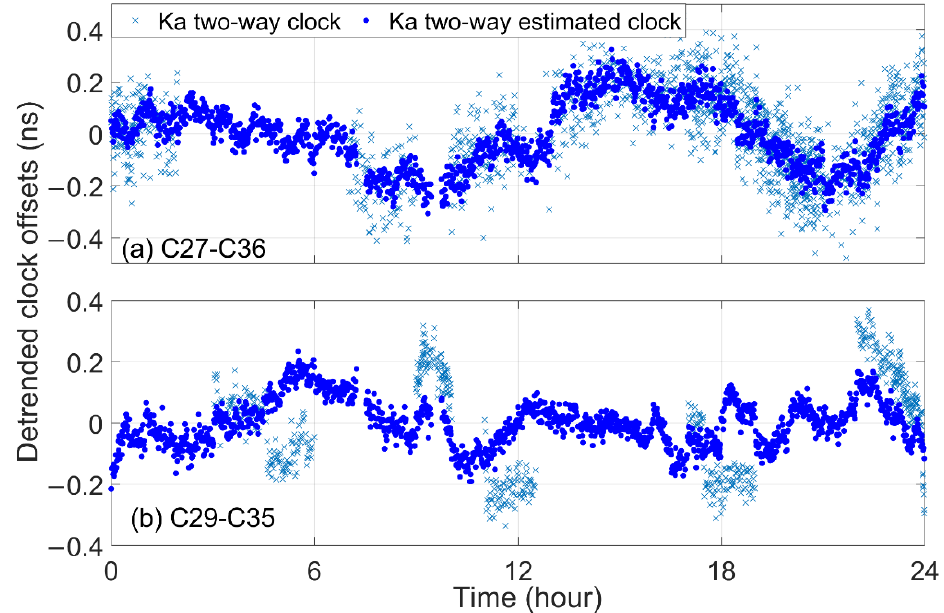
Figure 6. The improvements after using redundant Ka-band inter-satellite clock offsets to estimate Ka-band inter-satellite clock offsets (since 19 May 2022).